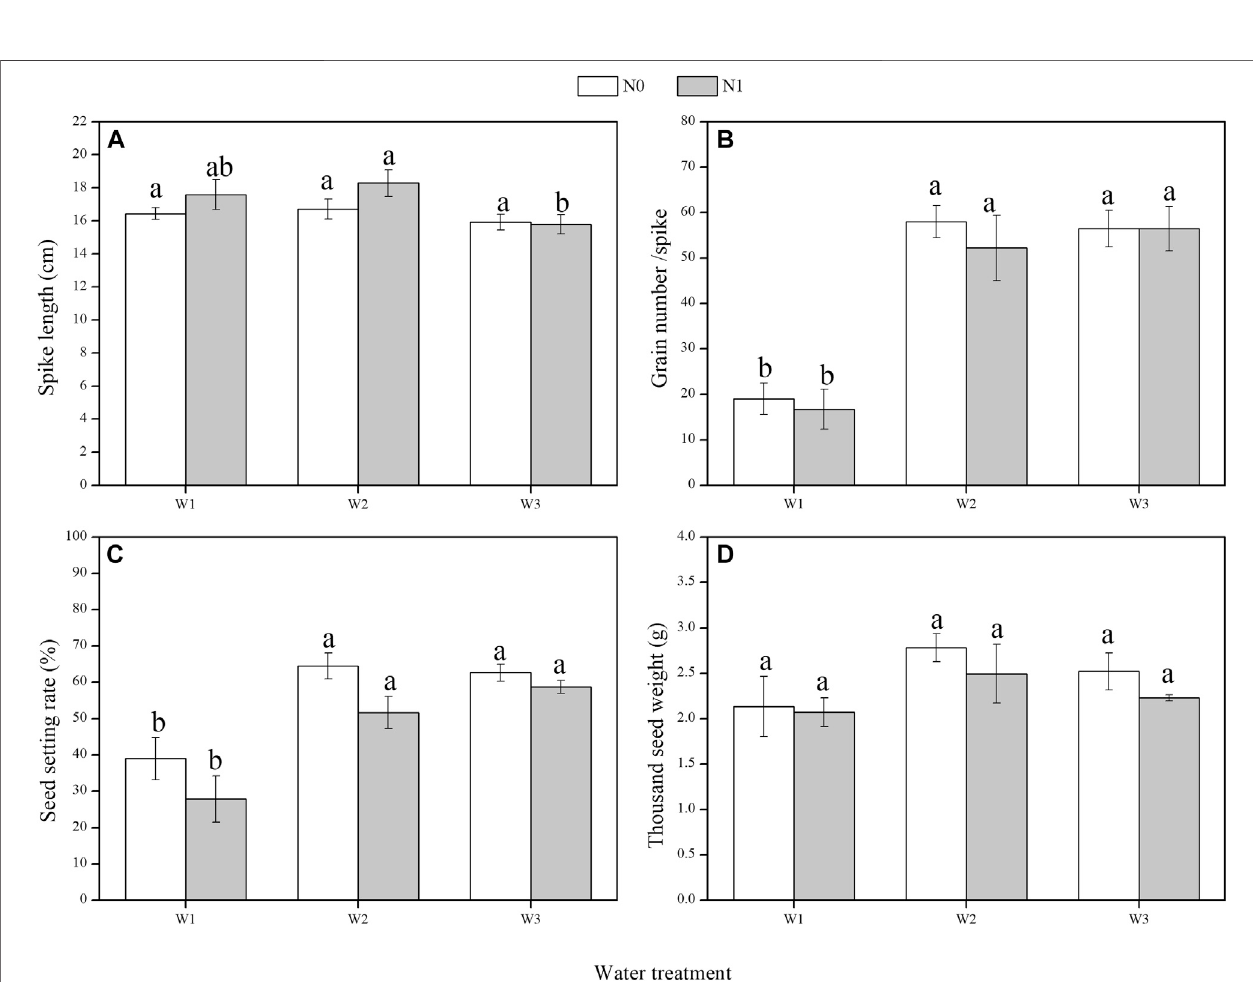
FIGURE1| Effectsofwaterandnitrogenonyieldcomponentsof L.chinensis (mean ± SE).N 0 ,control,withoutNapplication;N 1 ,Nappliedasureaat10.5 gN/m 2 ; W 1 , 50% mean annual precipitation (249 mm) (irrigation amount: 96 ml per pot); W 2 , mean annual precipitation (498 mm) (irrigation amount: 193 ml per pot); and W 3 , 150% mean annual precipitation (747 mm) (irrigation amount: 289 ml per pot). Different lowercase letters indicate signi fi cant differences ( p < 0.05) among water treatments at the same level of N